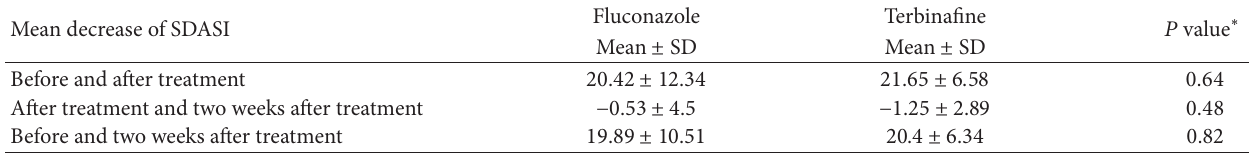
Table 2: The effects of terbinafine and fluconazole on decreasing of SDASI.